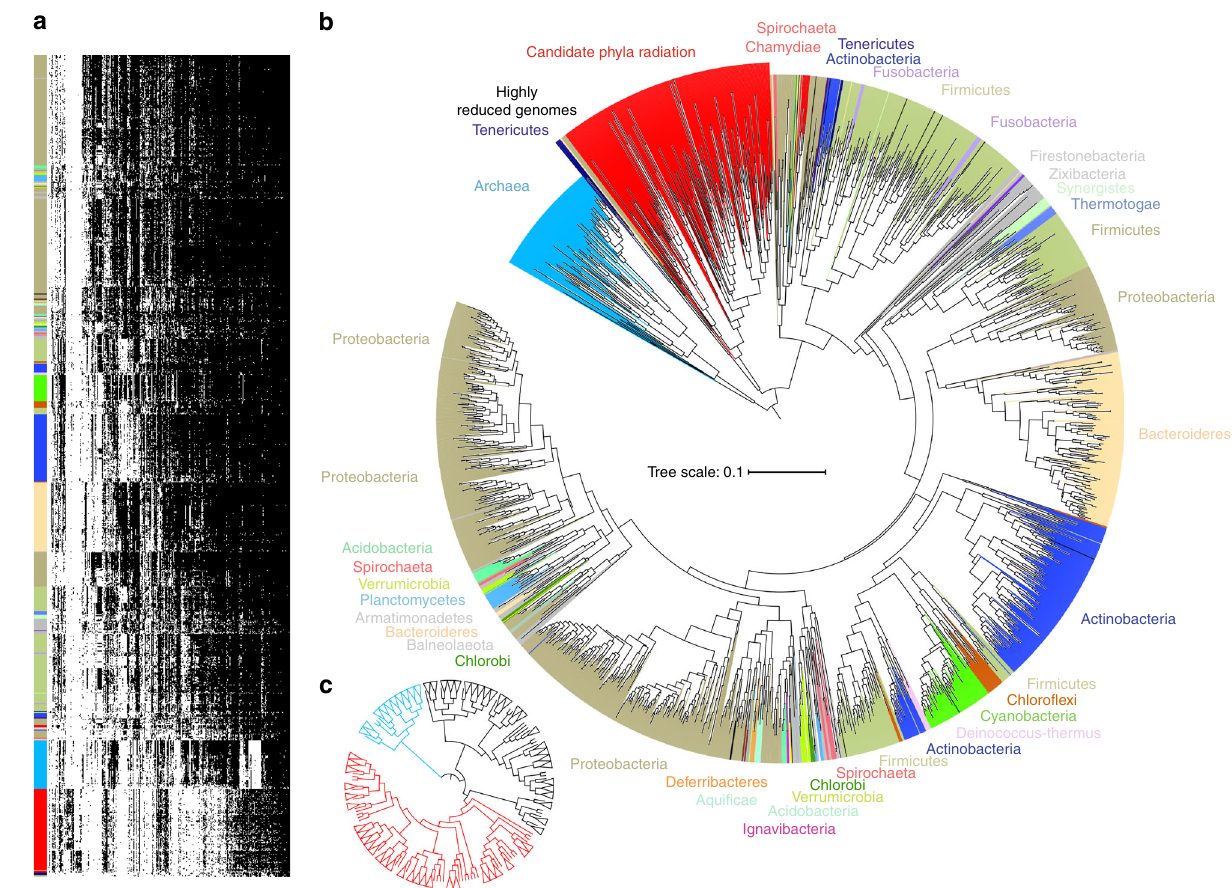
Fig. 4 The distribution of protein families across representative genomes of the prokaryotic tree of life. a The distribution of 921 widely distributed protein families (columns) in 2616 draft-quality and non-redundant genomes (rows) from a reference set with extensive sampling of genomes from non-CPR bacteria. Genomes are clustered based on the presence (black)/absence (white) pro fi les (Jaccard distance, complete linkage). The order of the families is the same as in Fig. 3a. b Tree resulting from the hierarchical clustering of the genomes based on the distributions of proteins families in panel a. c The same tree with a collapsing of all branches that represented <25% of the maximum branch length (CPR are in red, Archaea in blue and non-CPR bacteria in